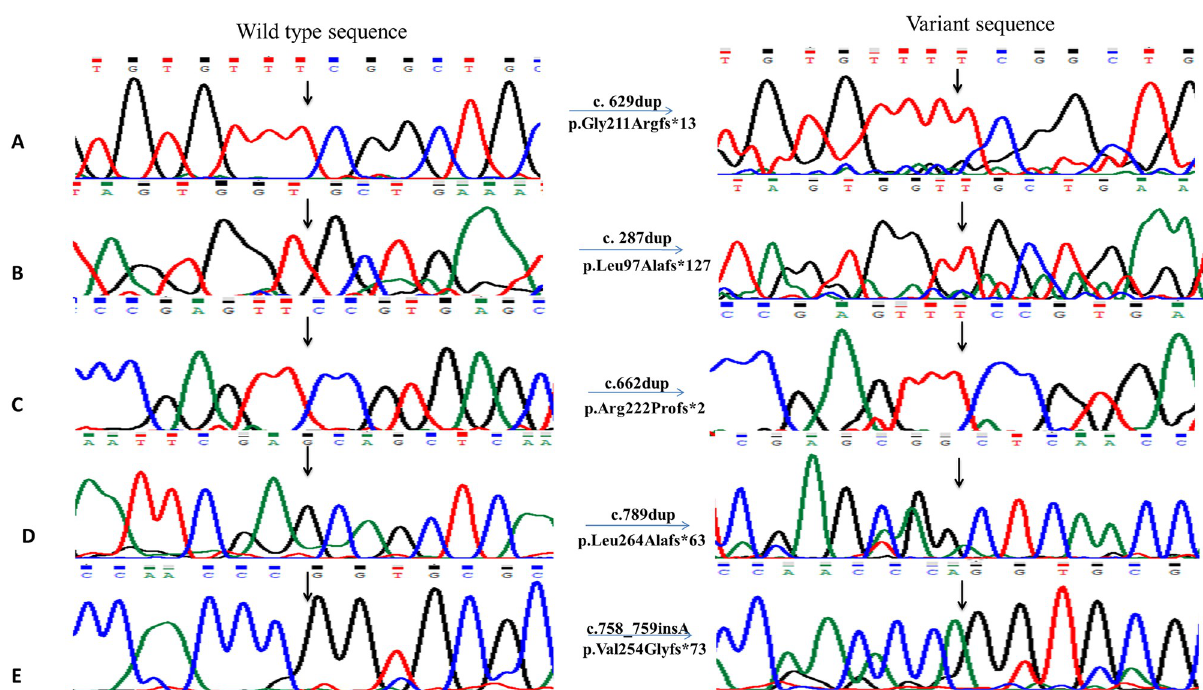
Fig 2. Chromatograms of novel duplications and an insertion detected in PCG patients. A) A homozygous variant c.629dup detected in PCG050 leading to p.Gly211Argfs � 13. B) Chromatogram of homozygous variant c.287dup detected in PCG053 that resulted in protein change i.e., p. Leu97Alafs � 127. C) Sequence chromatogram of homozygous variant c.662dup leading to protein change p.Arg222Profs � 2 in PCG054. D) Chromatogram showing c.789dup homozygous variant in PCG063 leading to a p.Leu264Alafs � 63. E) Homozygous insertion c.758_759insA detected in PCG059 resulting in p.Val254Glyfs � 73. All the chromatograms on left side indicate normal sequence while right side of figure shows mutated chromatograms.